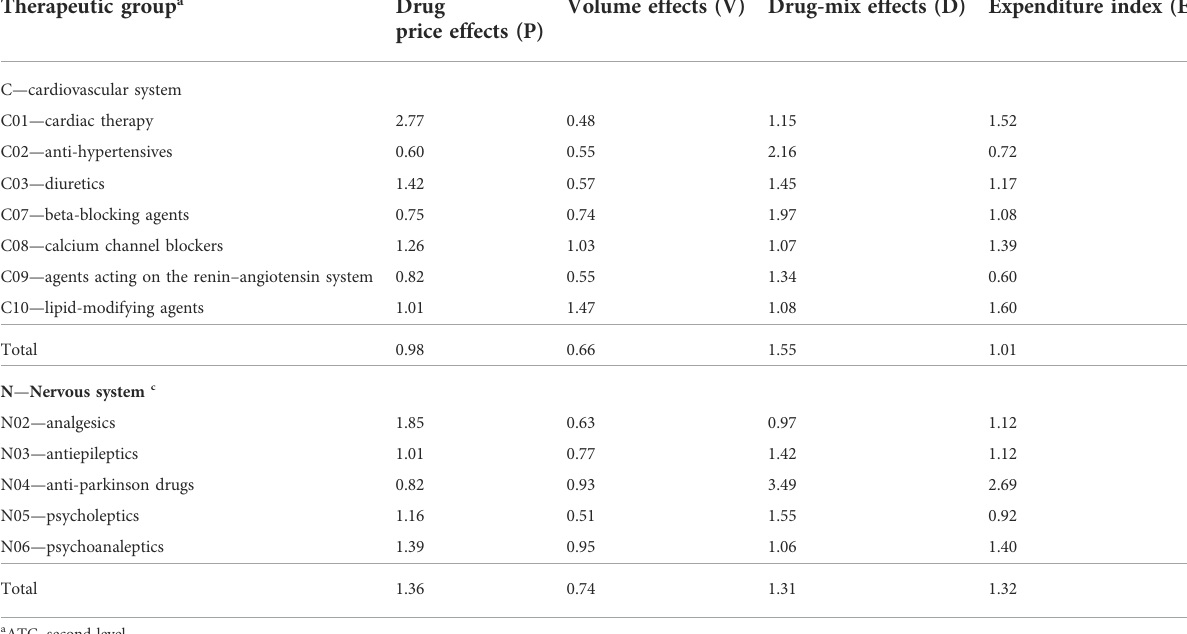
TABLE 4 Results of the decomposition analysis by cardiovascular and nervous system groups. Minas Gerais, Brazil, 2012 – 2018. Therapeutic group